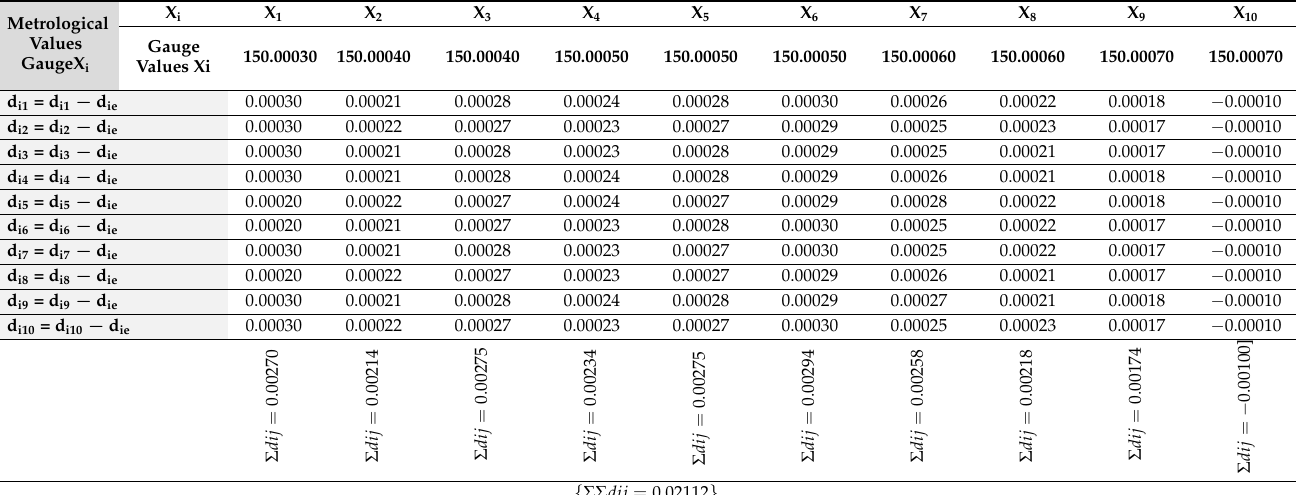
Table 7. Protocol of metrological measurements for determination of metrological values